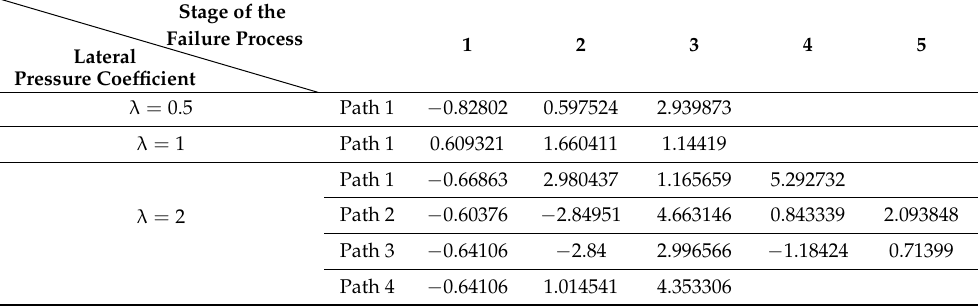
Table 6. Impact of failure of the different parts on the structure reliability.